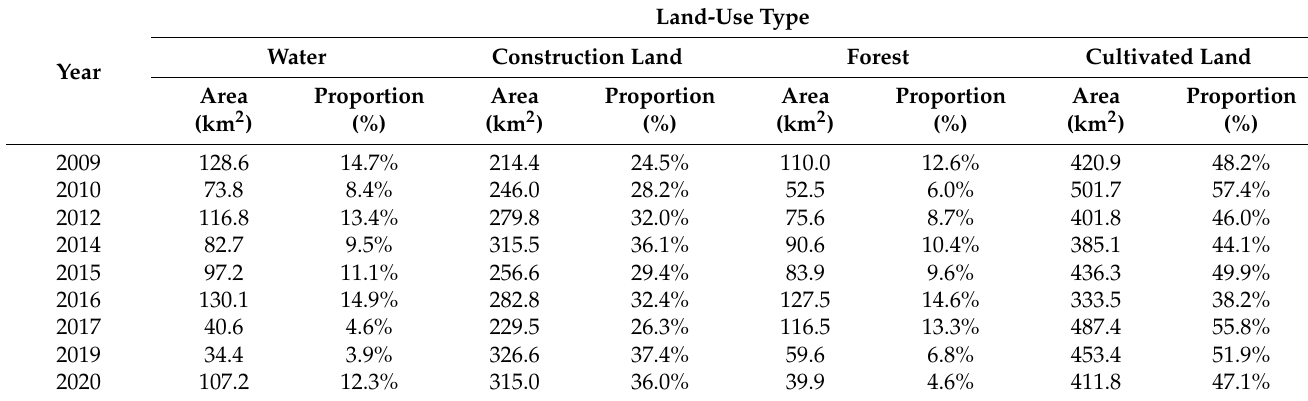
Table 4. Land-use change from 2009 to 2020.